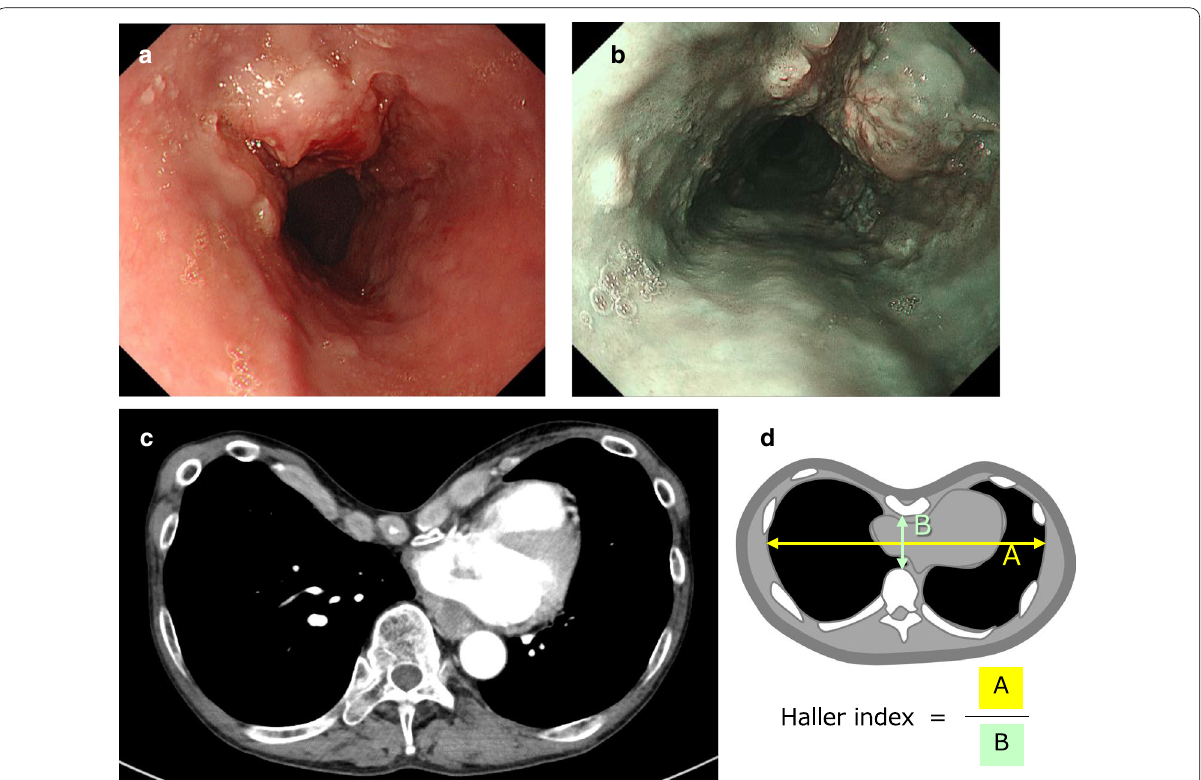
Fig. 1 Patient 1. a Endoscopic findings. An elevated tumor with flat mucosal erosion was detected 33–38 cm from the upper incisors and suspected muscle invasion. b Narrow band imaging. c Contrast-enhanced CT reveals a hypovascular mass lesion in the middle esophagus and pectus excavatum. The Haller index score was 8.5. d Schema of the Haller